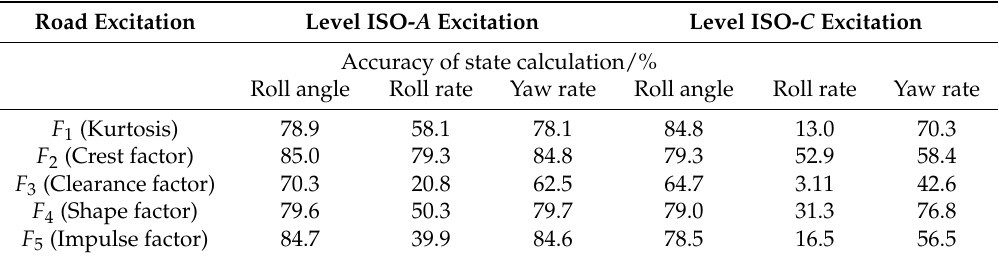
Table 9. Simulation accuracy of comparing 6-DOF model and CARSIM ® with steering wheel 15 ◦ input. Road